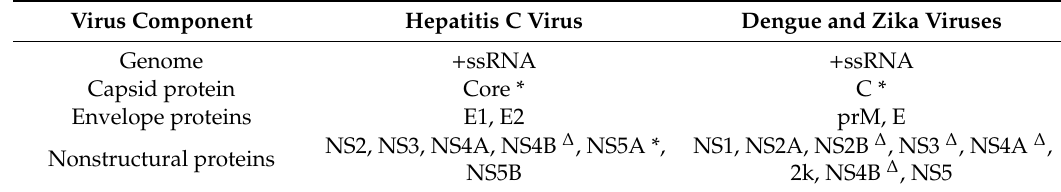
Table 1. Summary of selected hepacivirus and flavivirus structural and non-structural (NS)